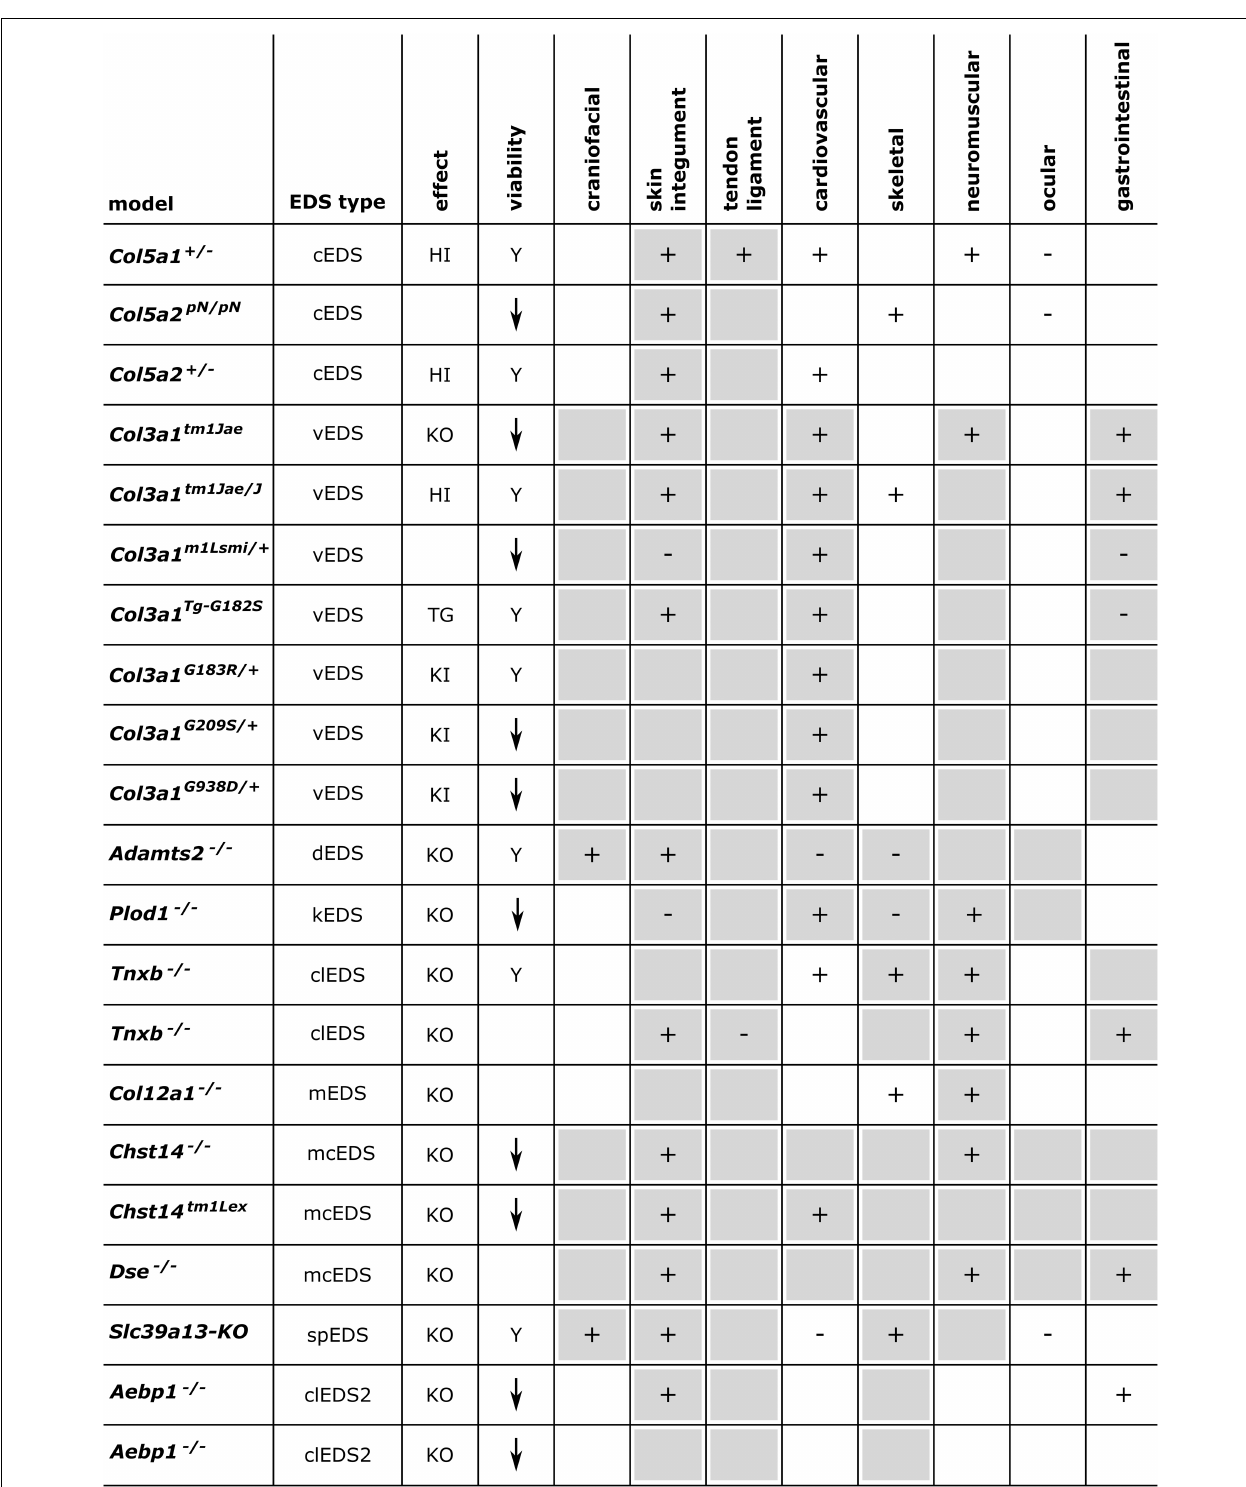
FIGURE 3 | Phenotypic characteristics of mouse models with defects in EDS-associated genes. The presence or absence of a phenotype in mice is indicated with “+” or “-”, respectively, when investigated. A detailed description of the murine phenotypes can be found in Supplementary Table 1 . The major and minor clinical characteristics in human EDS patients as defined in the International EDS Classification, published in 2017, are indicated with a gray background (Malfait et al., 2017). HI, haploinsufficiency; KO, (homozygous) knockout; TG, transgenic; KI, knock-in; Y, viable; ↓ , decreased survival rate.